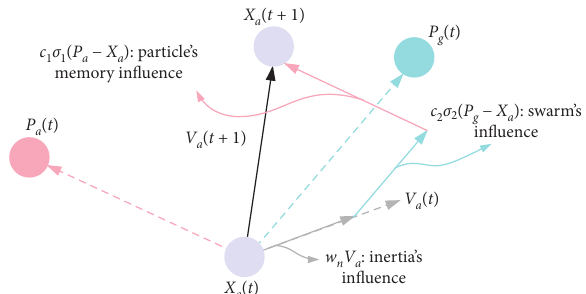
Figure 7: Graphical illustration of the a th particle’s subcomponents that form its updated velocity vector, V a ( t + 1 ) , at the execution instant t of the PSO. The updated velocity is a linear combination of its current velocity, V a ( t ) , and its relative displacements from its own and the population’s fittest position values, P a ( t ) and P g ( t ) ,